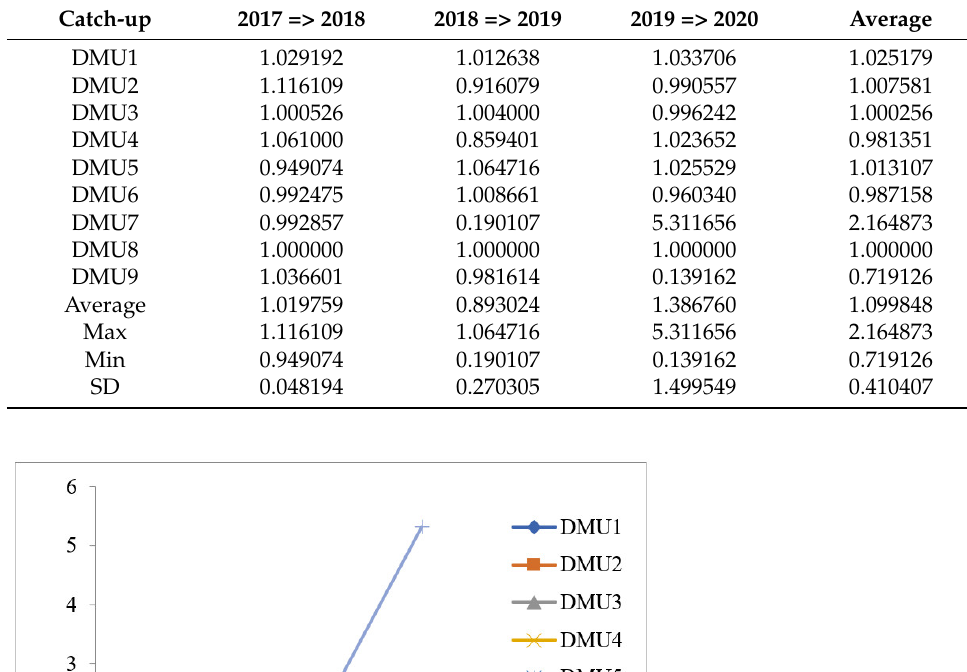
Table 3. Catch-up index over the period 2017–2020.